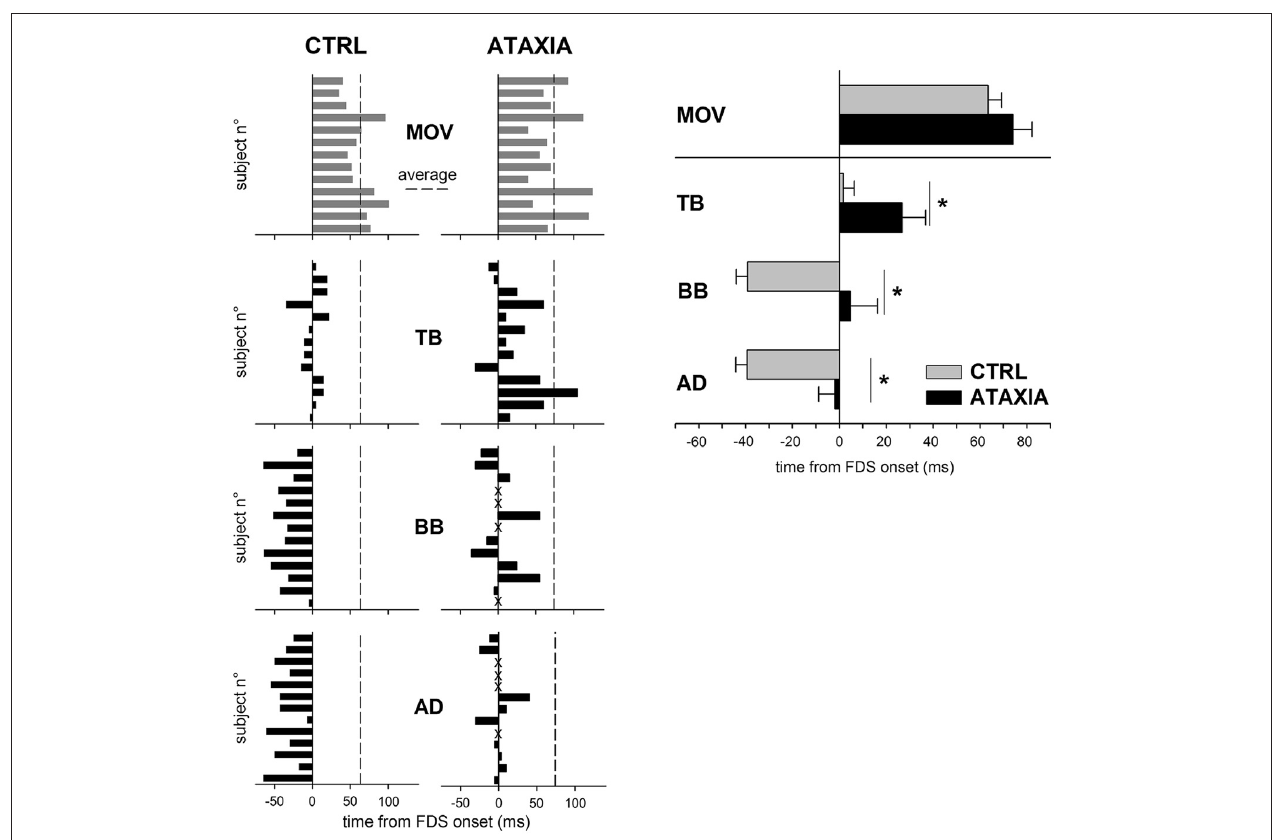
FIGURE 4 | Comparison of the APA chain in healthy (CTRL) and in cerebellar (ATAXIA) subjects. Latencies of finger flexion (MOV) and APA onsets in TB, BB and AD are plotted with respect to the onset of FDS, prime mover. Each single subject is represented. Dashed line marks the average movement latency for either group of subjects. Note that in ATAXIA APAs are delayed or, in some cases absent (marked with X). The right panel shows mean latency ( ± SE) of the onset of finger flexion and APAs. Asterisks mark significant differences found by the unpaired t -test. Reproduced from Bruttini et al. (2015), © Springer-Verlag Berlin Heidelberg 2014, with permission of Springer